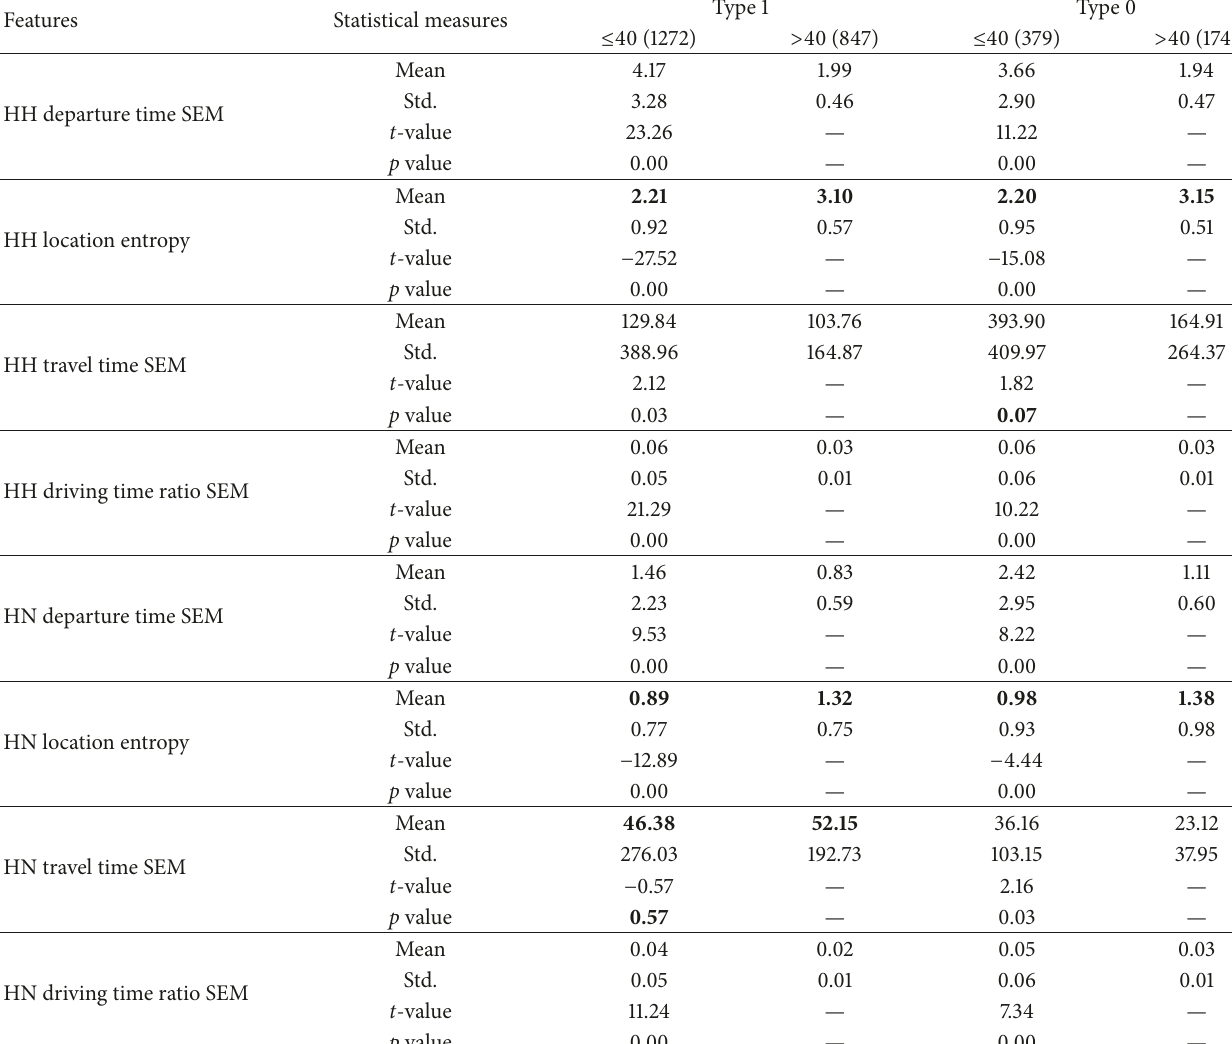
Table 7: Statistical analysis of variances of travel behavior features for